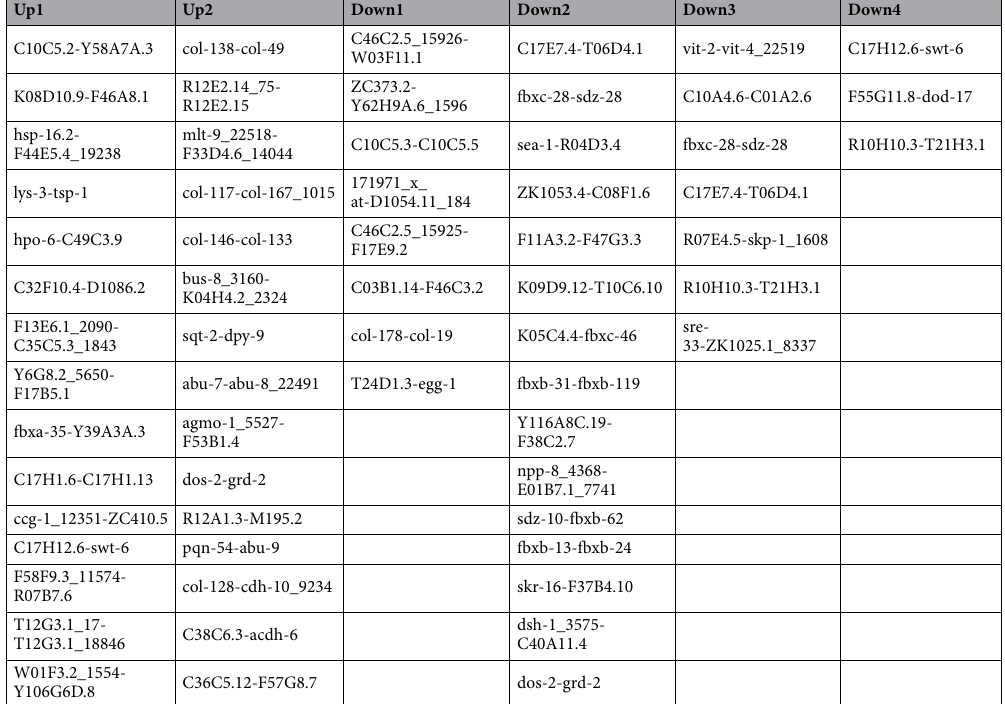
Table 5. HSP-90-responsive cliques with highest enrichment of daf-16 supported (red) and suppressed (blue) genes. Sorted according to the nomenclature estabilshed in Eckl et al., 2017, which grouped the hsp-90 responsive genes in two major groups for upregulation and four groups for downregulation based on co-expression network analysis. Cliques enriched within these groups are listed under the group names (Up1, Up2, Down1, Down2, Down3 and Down4). The groups are labeled in bold, if enrichment reaches the significance level of 1e-5 and they are colored, if the same group is found within the top daf-16 regulated groups. Coloring is red, if it is among upregulated DAF-16 targets and blue if, it is among down regulated DAF-16